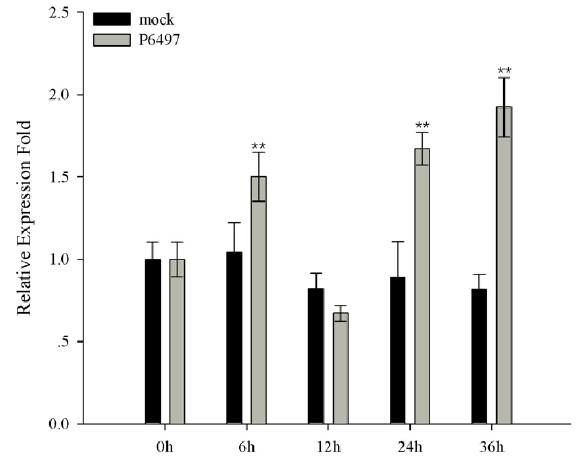
Figure 6. Expression profiles of GmMED16-1 under Phytophthora sojae inoculation. Leaves from the seven days old seedlings were used for P. sojae infection. The mock control was treated with the V8 medium without P. sojae . Samples were collected from the inoculated area as well as the mock control at 0, 6, 12, 24, and 36 h post-infection (hpi). The expression levels are normalized to GmCons4 gene as an endogenous control. ** indicate significant difference from control at p < 0.01, respectively.